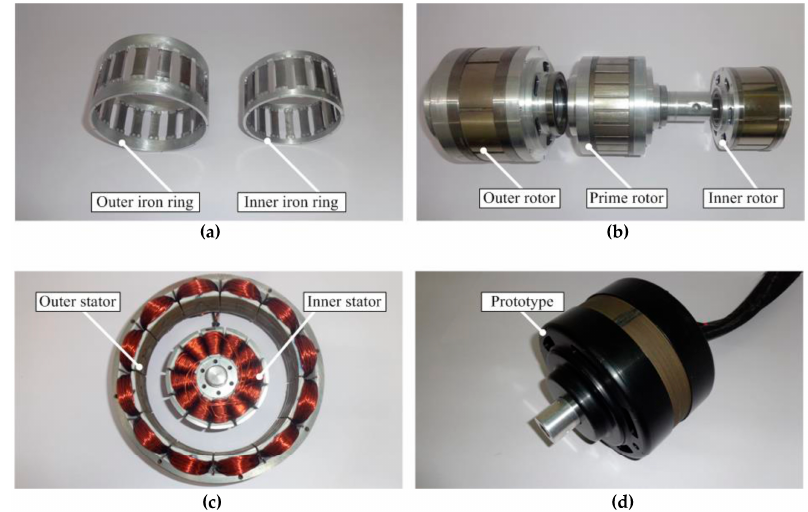
Figure 17. The fabricated components and prototype of DS-MGM: ( a ) Iron rings; ( b ) Rotors; ( c ) Stators; ( d ) Assembled prototype.